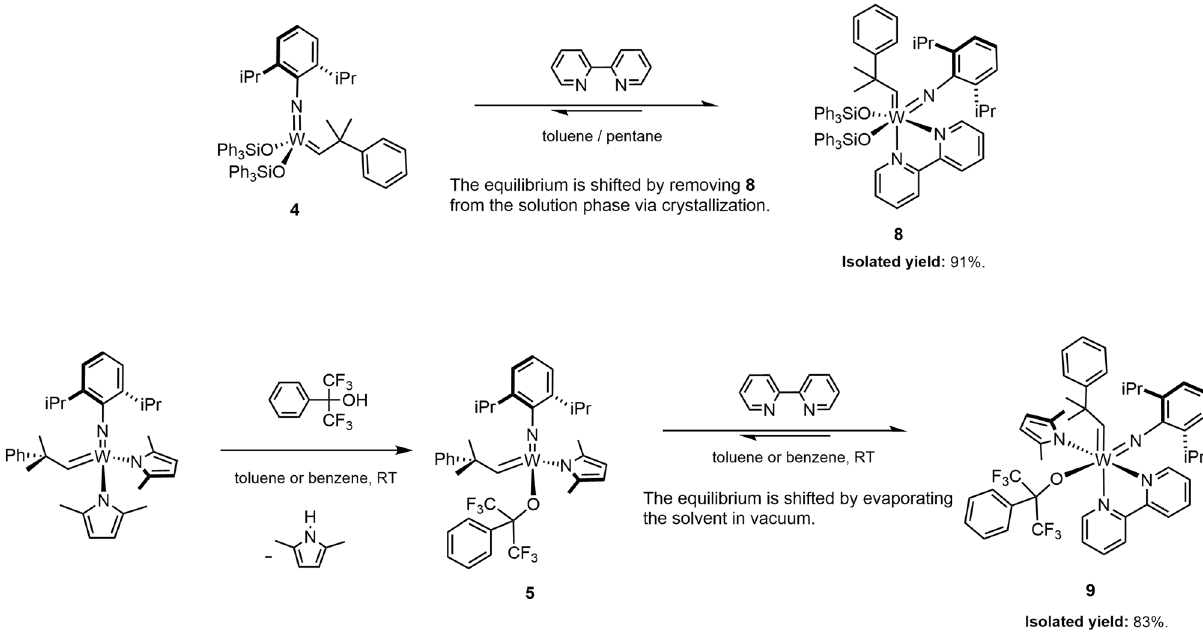
Fig. 4 Isolation of the labile 18-electron adducts 8 and 9. The equilibria can readily be shifted towards the adduct formation either by in situ crystallization of the adduct, or by concentrating the reaction mixture, allowing the isolation of 8 and 9 in excellent yields.